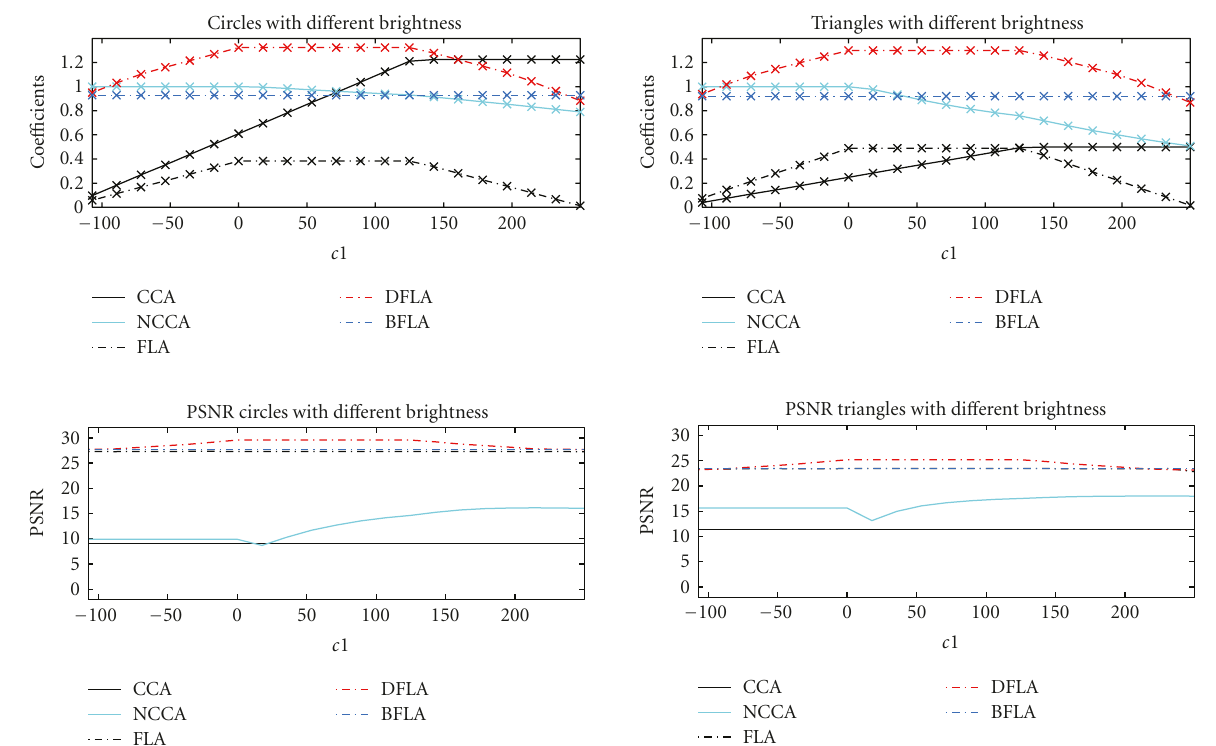
Figure 5: Influence of changes in brightness on the coe ffi cients and the PSNR of the cross-correlation algorithms (change of c 1 (16)). Top: coe ffi cients of the correlation algorithms, (marker—correct position found); bottom: PSNR of the correlation algorithms; left: results of the circles; right: results of the